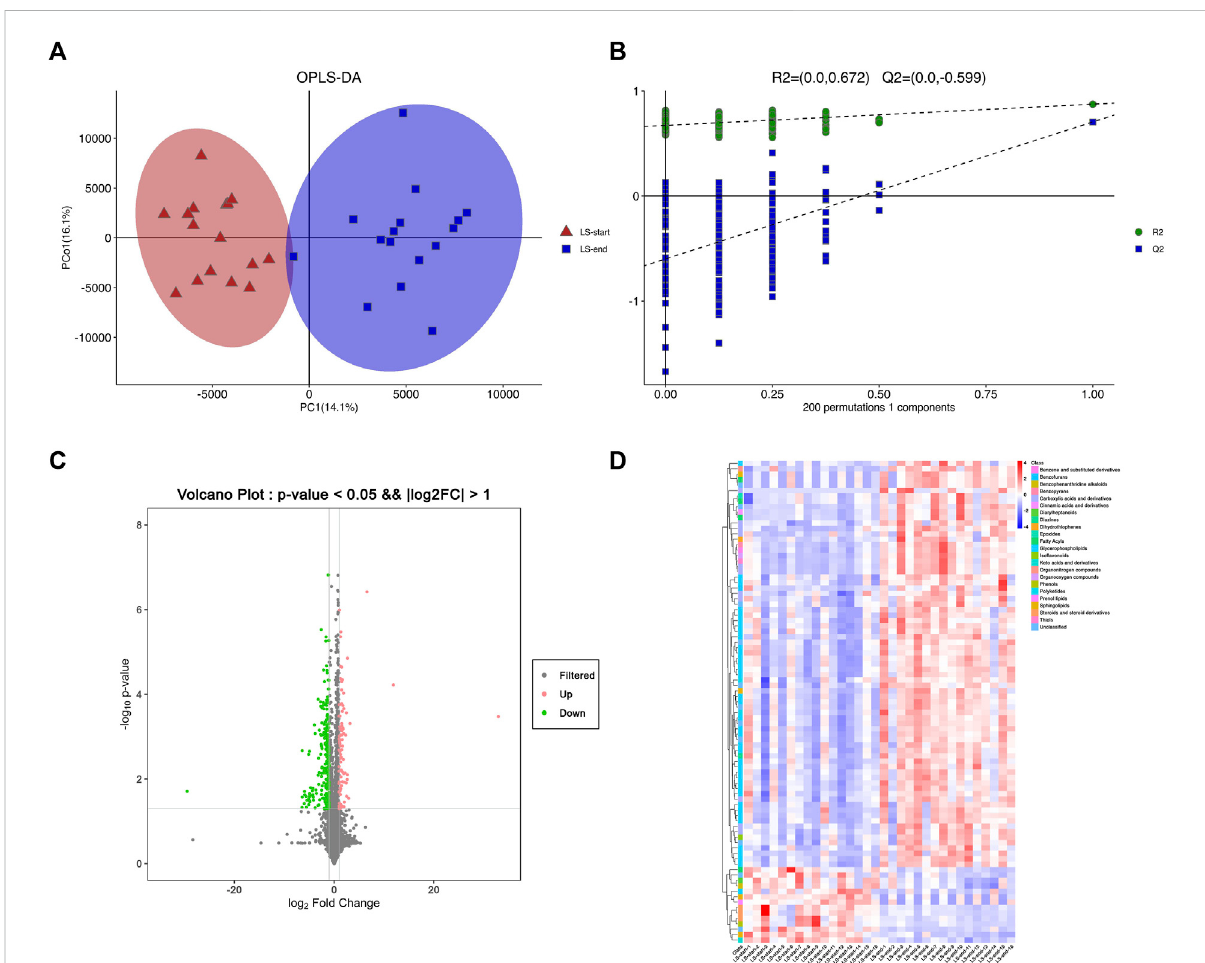
FIGURE 3 Serummetabolomicswasusedtoquantifymetabolitesinthestart-andend- LSgroups. (A) OPLS-DAplotshowingthespatialdivisionbetween start- and end- LS groups. (B) Alignment diagram of correlation coef fi cients of OPLS-DA model. (C) Volcano plot showing the metabolites that differed cumulatively and signi fi cantly changed in start- and end- LS groups. (D) Heat map of the association between 89 metabolites and start/end LS